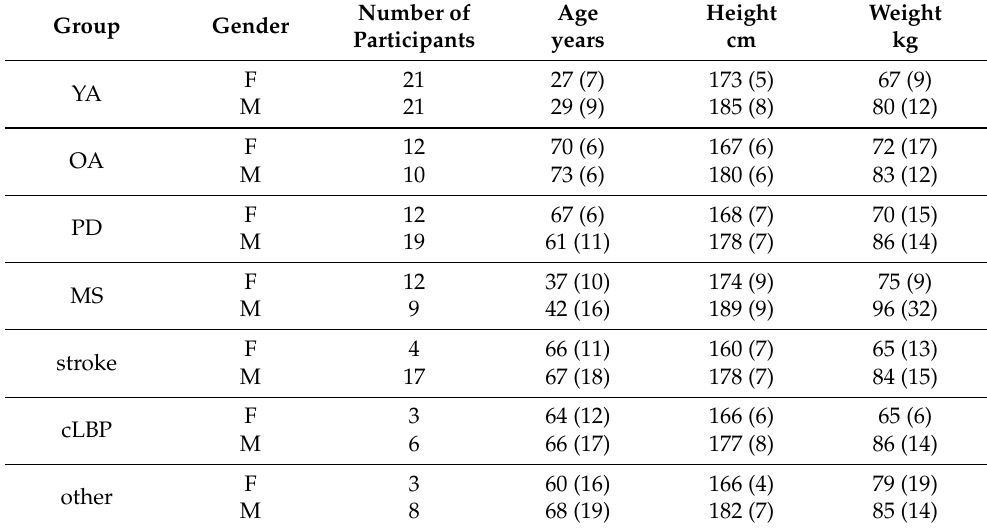
Table 1. Demographics data of the study participants. Age, height, and weight are presented as mean (standard